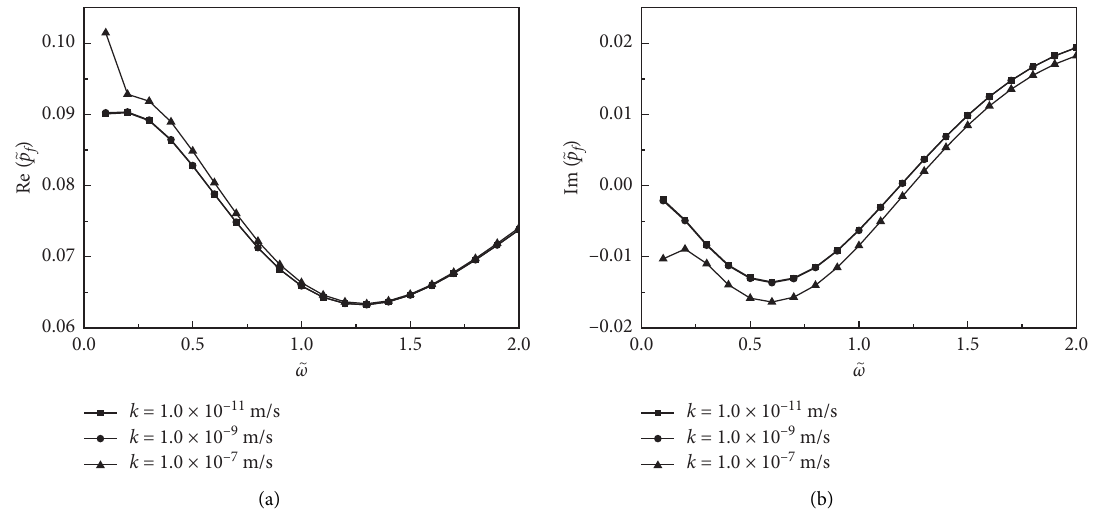
Figure 6: The pore pressure for the interface between the half spec and structure varied with the frequency: (a) real part of vertical displacement and (b) imaginary part of vertical